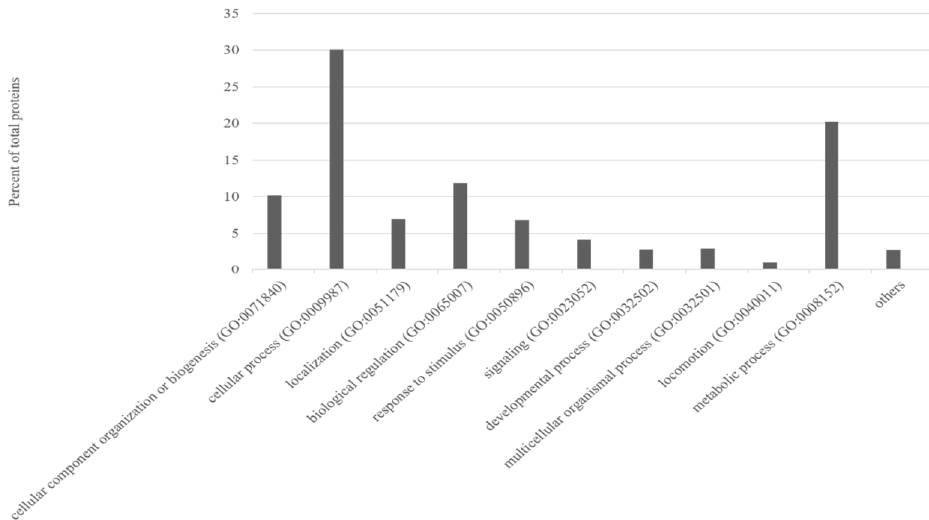
Figure 1. Percentage of proteins (over 2093 identified proteins; Tables S1 and S2) grouped according to different biological processes.